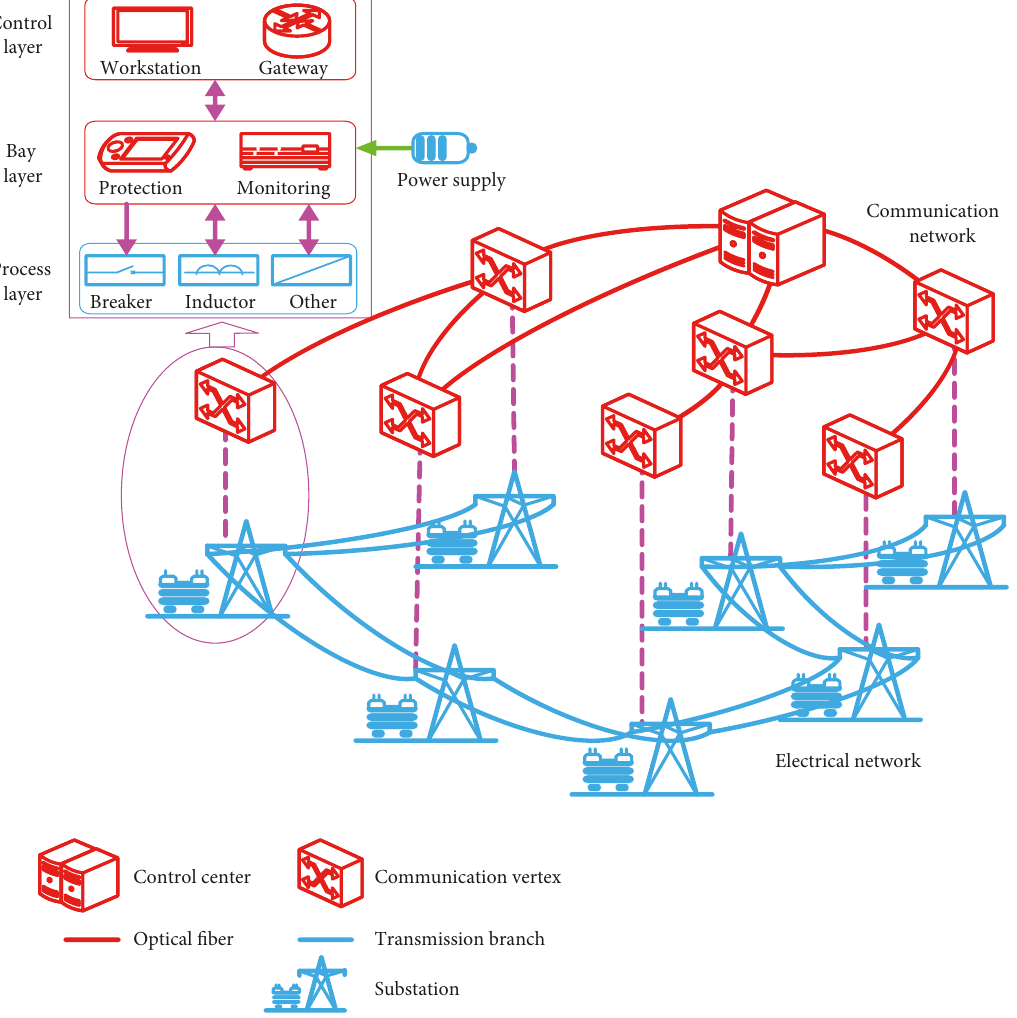
Figure 1: Diagram of ECN in smart